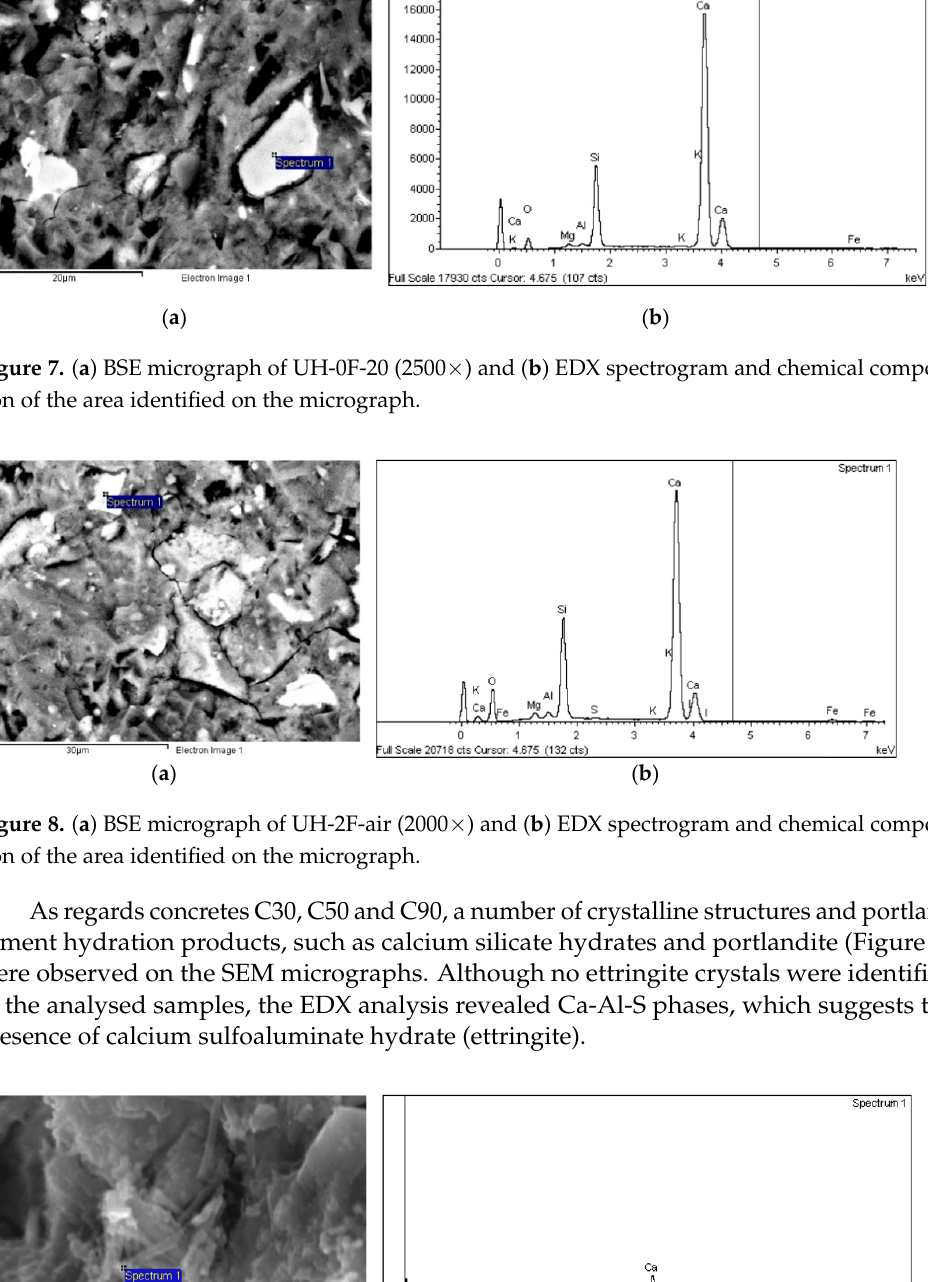
The TG and derivative TG (DTG) curves determined by means of TGA are plotted in Figure in Figure 10.